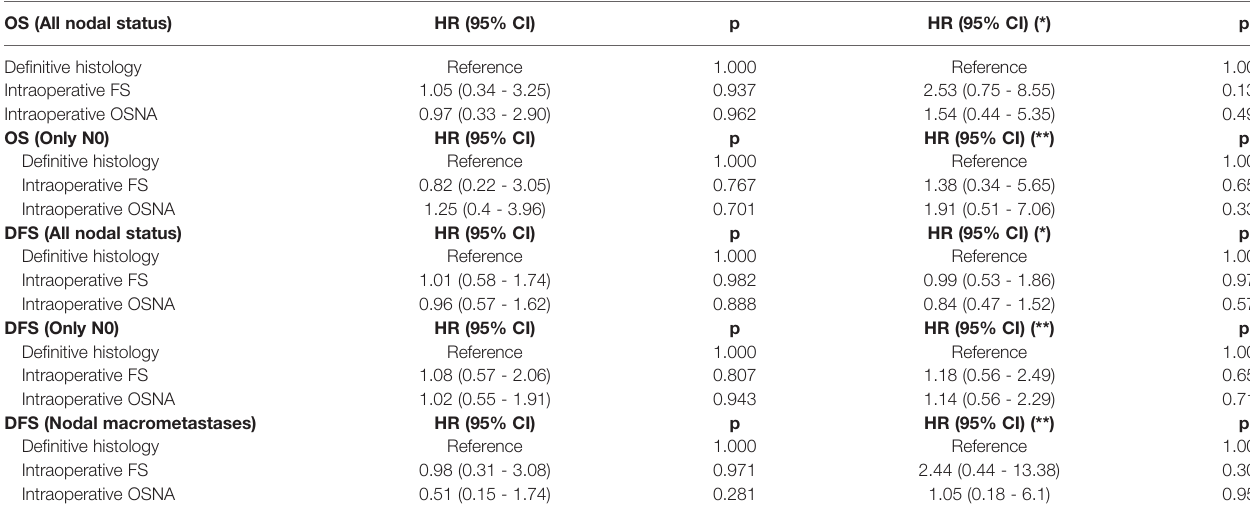
TABLE 4 | Univariate and multivariate Cox analysis.